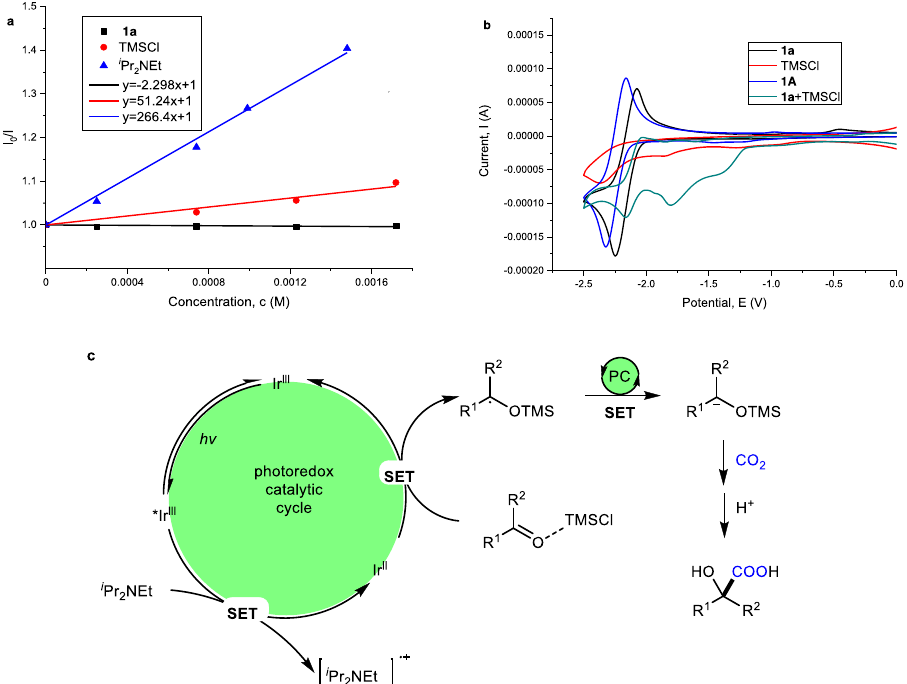
Fig. 9 Mechanistic experiments and proposed mechanism. a Stern-Volmer experiment. b Cyclic voltammetry (CV) tests. c Proposed mechanism.